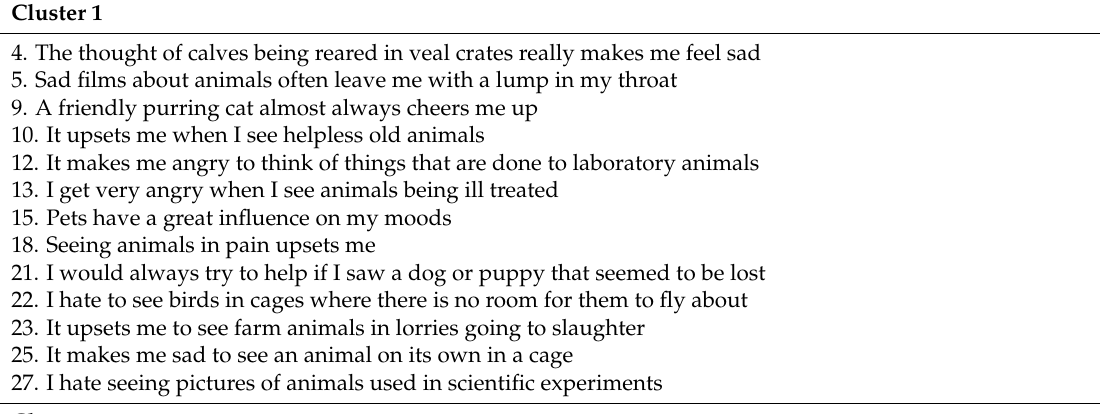
Table 4. The Ward Hierarchical Clustering analysis for participants’ responses ( n = 41) regarding emotional empathy with